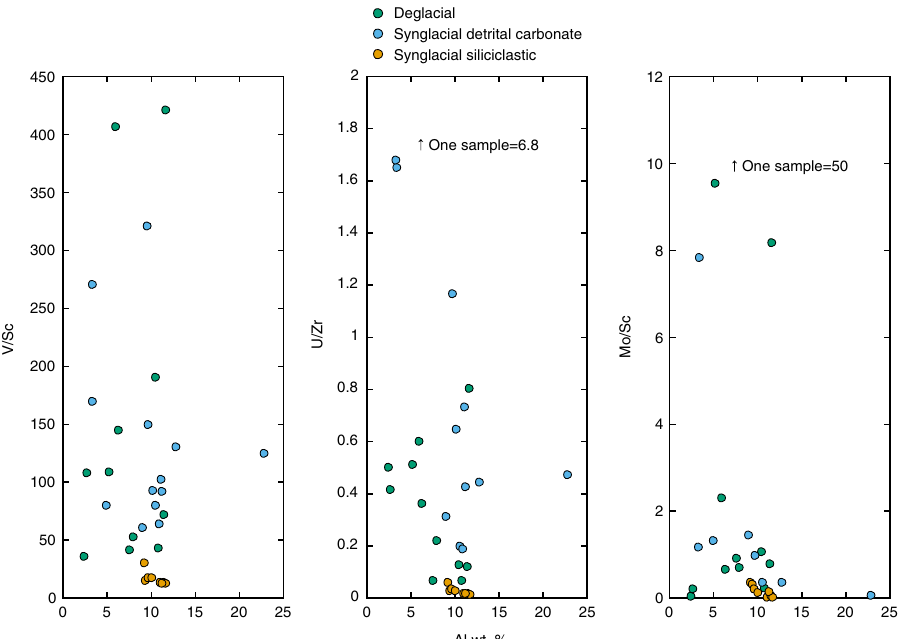
Fig. 3 Detrital input test using Al. Whole-rock analyses of redox-sensitive trace elements of interest, normalized to geochemically similar but redox- insensitive elements and plotted against Al. If all variation seen in redox-sensitive trace elements were due to changes in detrital input alone, they would correlate to Al. Since this correlation is not seen, we suggest that variation in redox-sensitive trace elements is due to changes in water column